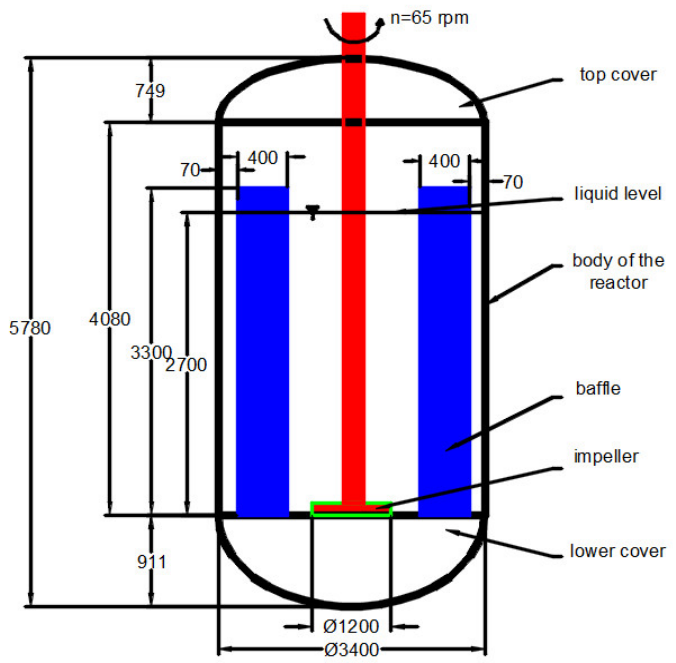
Figure 1. Schematic representation of the industrial reactor with original stirring mechanism fitted with the new designed impeller.